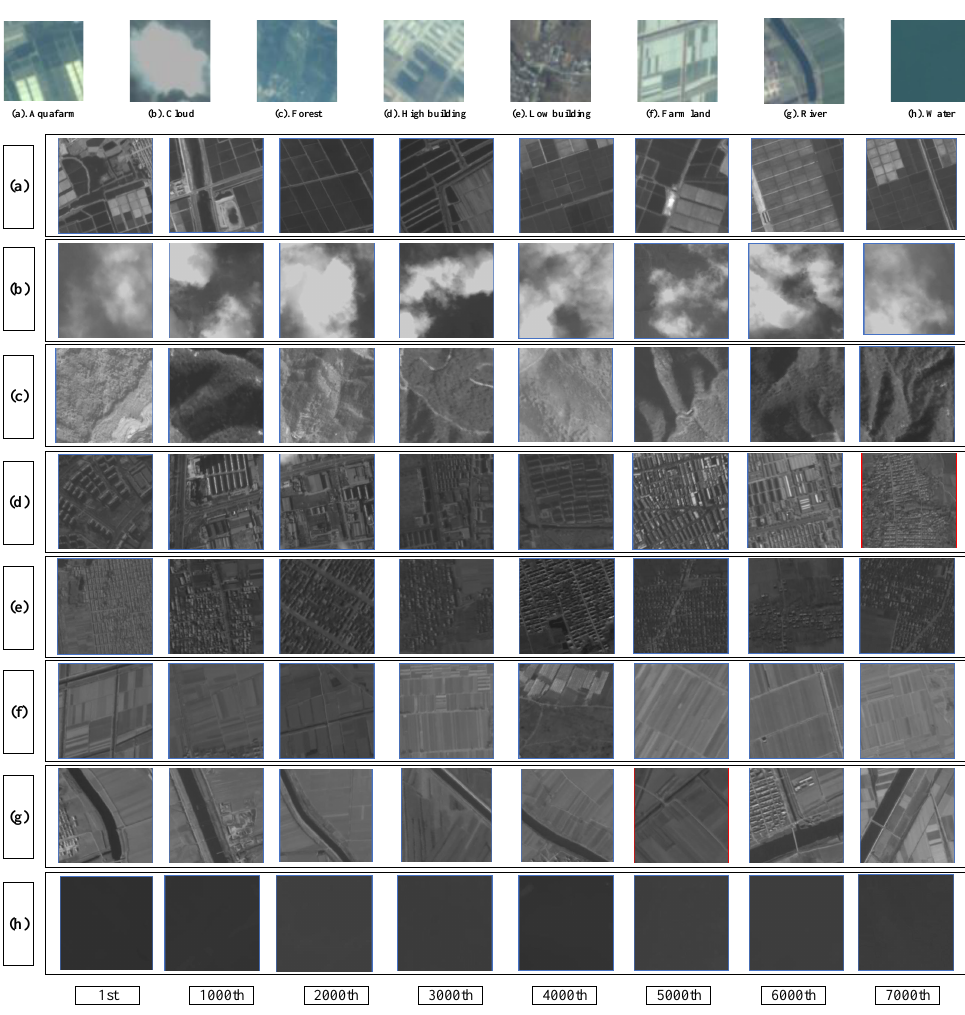
Figure 5. Visual retrieval results on cross-source MUL → PAN. Inquiry images in the first row are from a panchromatic source and they are picked from each class respectively. ( a – h ) are retrieved images for the corresponding inquiry images in the first row. The red rectangles denote the false retrieved images that are irrelevant to inquiry